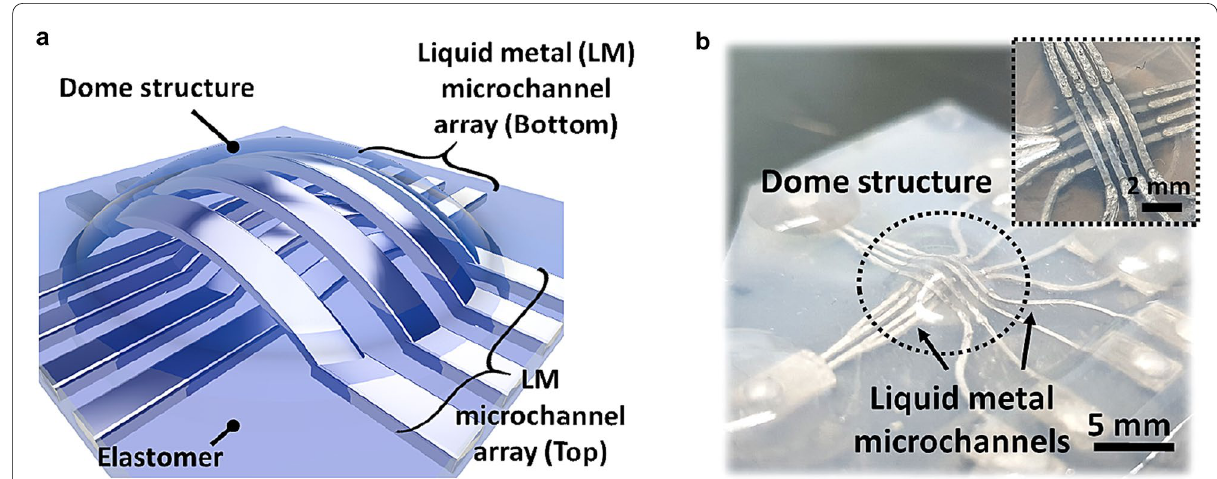
Fig. 1 Liquid metal-based multiaxial force sensor with dome structure. a Schematic design of the proposed sensor. b Images of the proposed